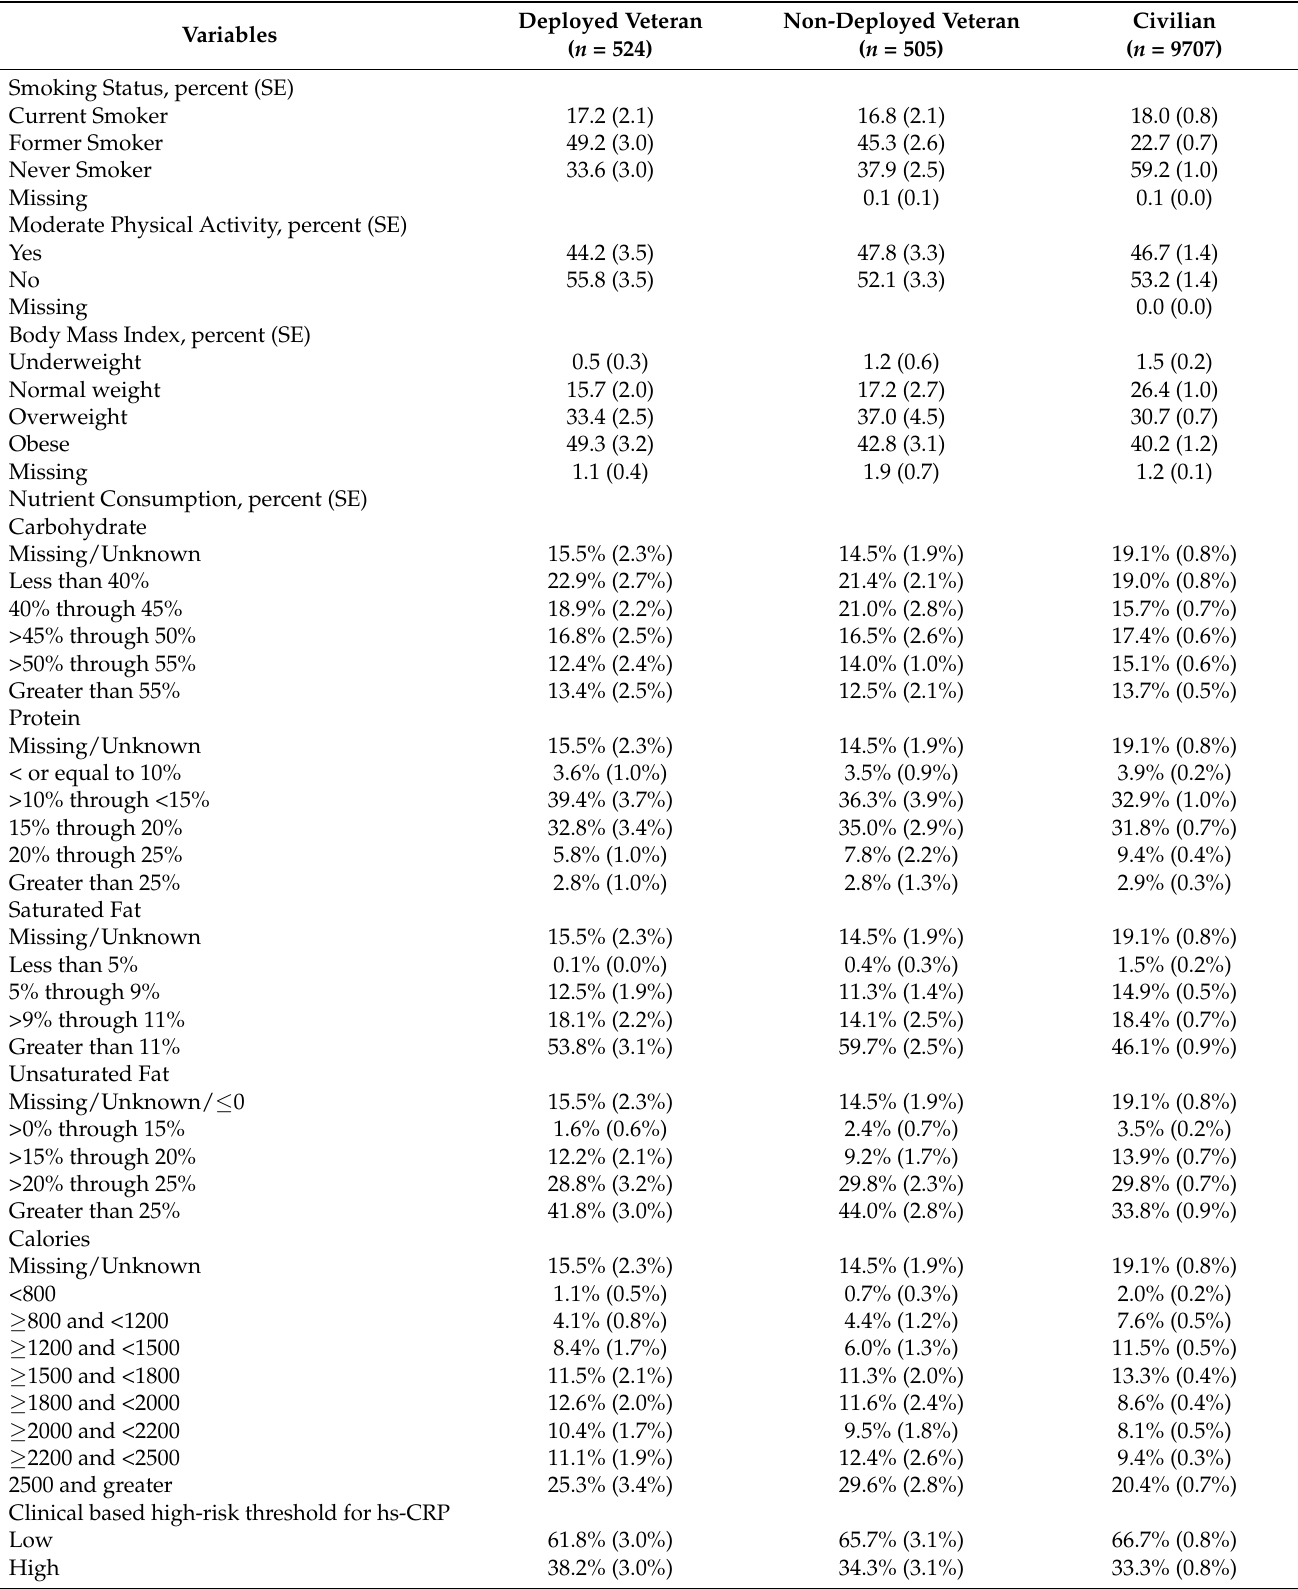
Table 2. Weighted behavioral, anthropometric, and clinical characteristics ( n =